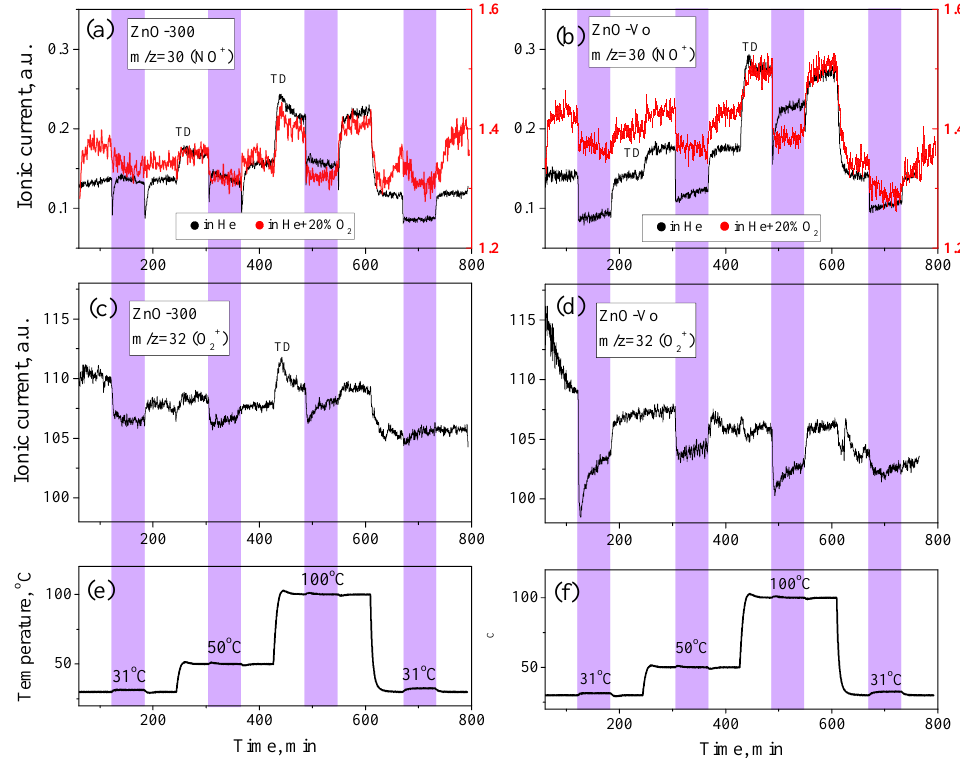
Figure 10. Changes in the ionic current during heating and UV illumination of ZnO tablets obtained from MS: ( a ) NO 2 ( m / z = 30) in an atmosphere of He/100 ppm NO 2 (black line) and He/20% O 2 /100 ppm NO 2 (red line) for ZnO-300 sample; ( b ) NO 2 ( m / z = 30) in an atmosphere of He/100 ppm NO 2 (black line) and He/20% O 2 /100 ppm NO 2 (red line) for ZnO-V O sample; ( c ) O 2 ( m / z = 32) in the He/100 ppm NO 2 atmosphere for ZnO-300 sample; ( d ) oxygen ( m / z = 32) in the He/100 ppm NO 2 atmosphere for ZnO-V O sample; ( e , f ) temperature profile of the